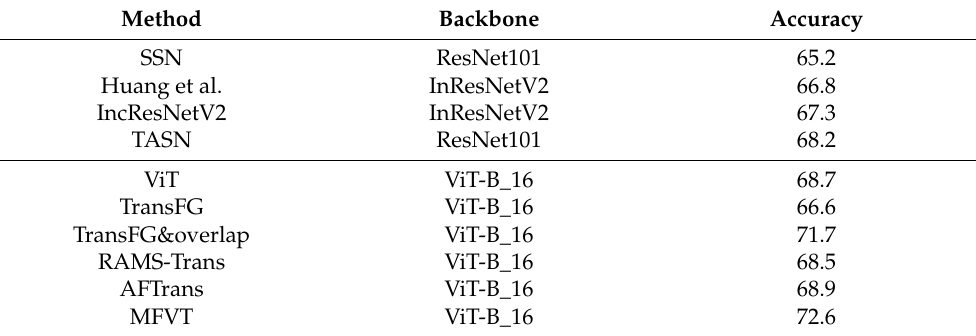
Table 7. Accuracy of different methods on iNaturalist 2017.